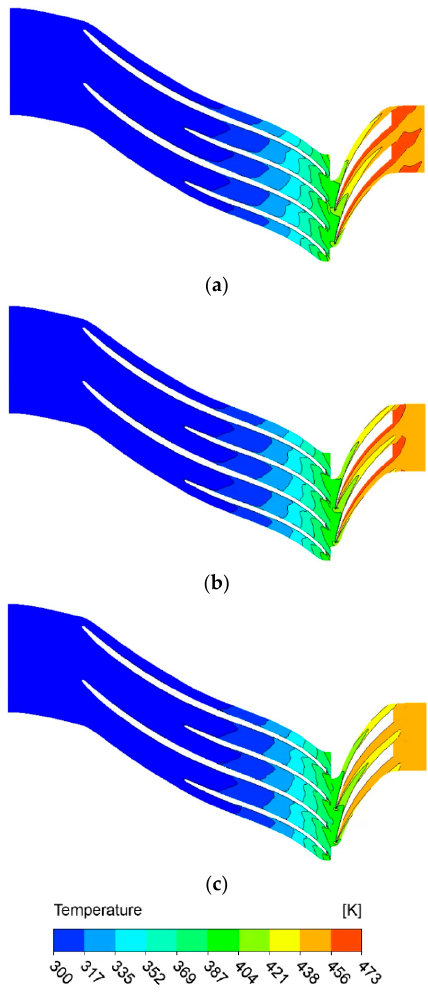
Figure 13. Comparison results of the temperature contour under different droplet mass flow rates at a span 50%. ( a ) 0.2% (0.00092 kg/s); ( b ) 0.6% (0.00276 kg/s); ( c ) 1% (0.0046 kg/s).